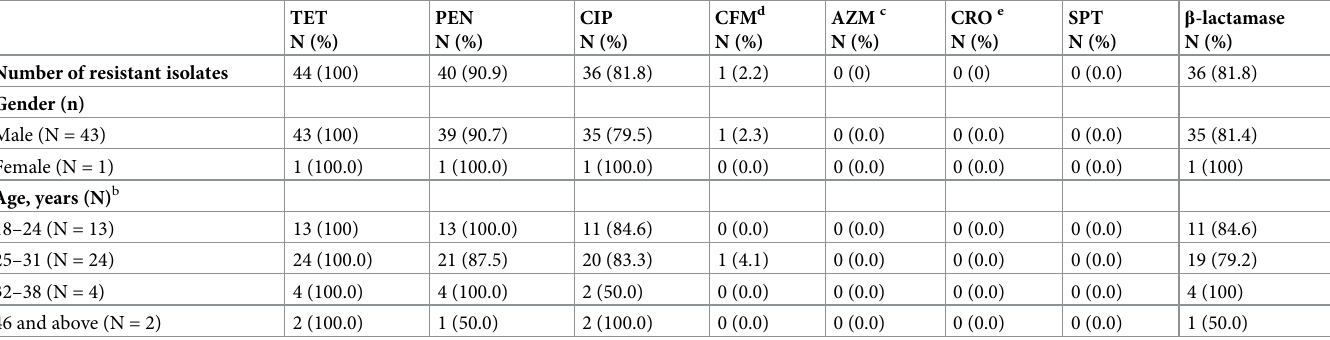
Table 1. Antimicrobial resistance determined by the Etest in Neisseria gonorrhoeae isolates from 44